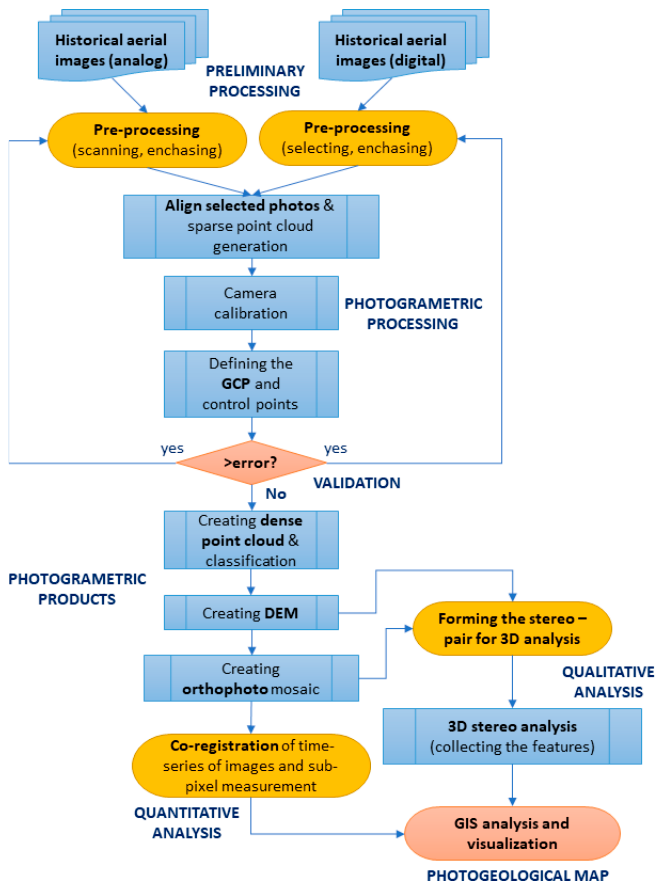
Figure 4. Algorithm of photogrammetric processing and analysis of historical aerial photographs for landslide monitoring.